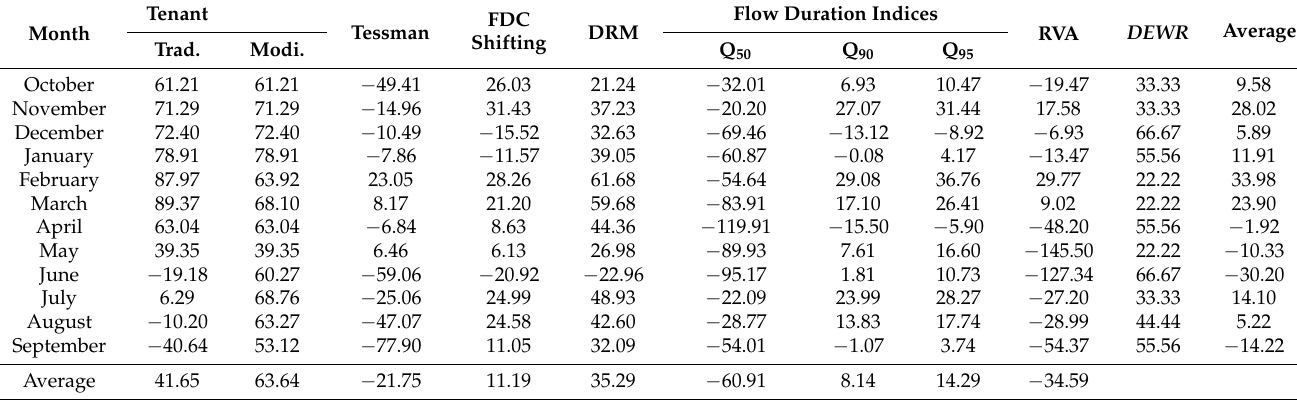
Table 11. AEWR percentage for the Kor River after the construction of the Mollasadra